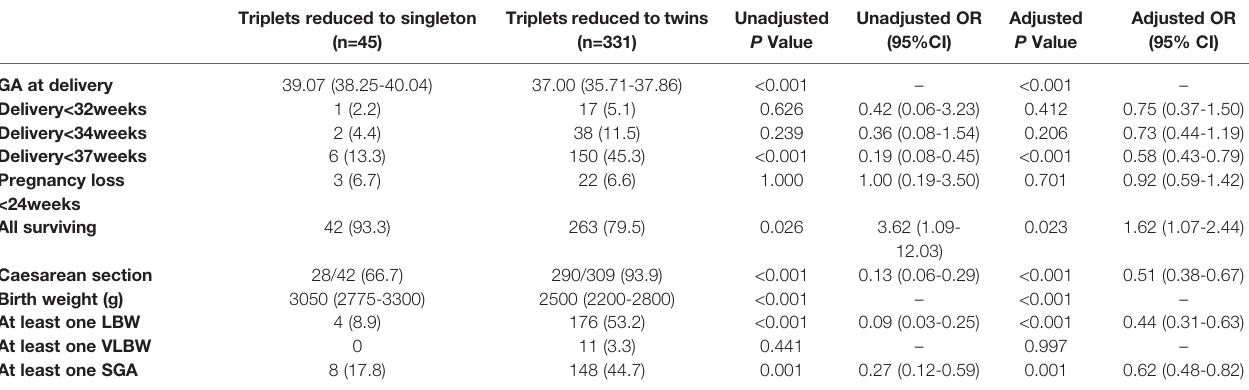
TABLE 2 | Pregnancy outcomes of triplets reduced to singletons versus triplets reduced to twins. Triplets reduced to singleton (n=45)